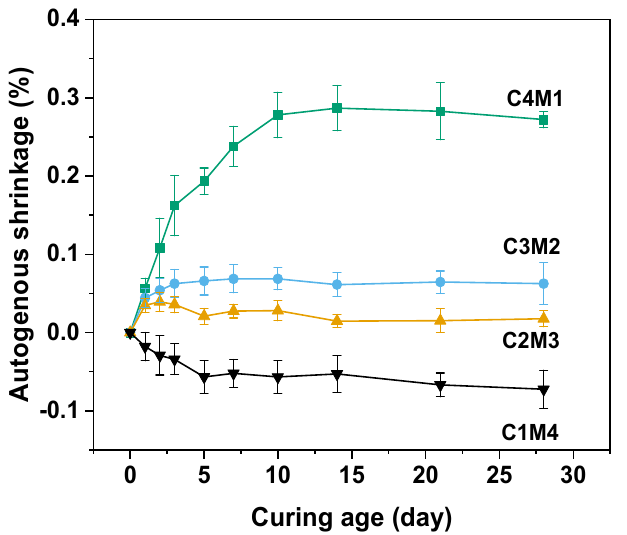
Figure 5. Autogenous shrinkage of the Na 2 CO 3 − activated slag binders modified with Ca(OH) 2 and Mg(OH) 2 .